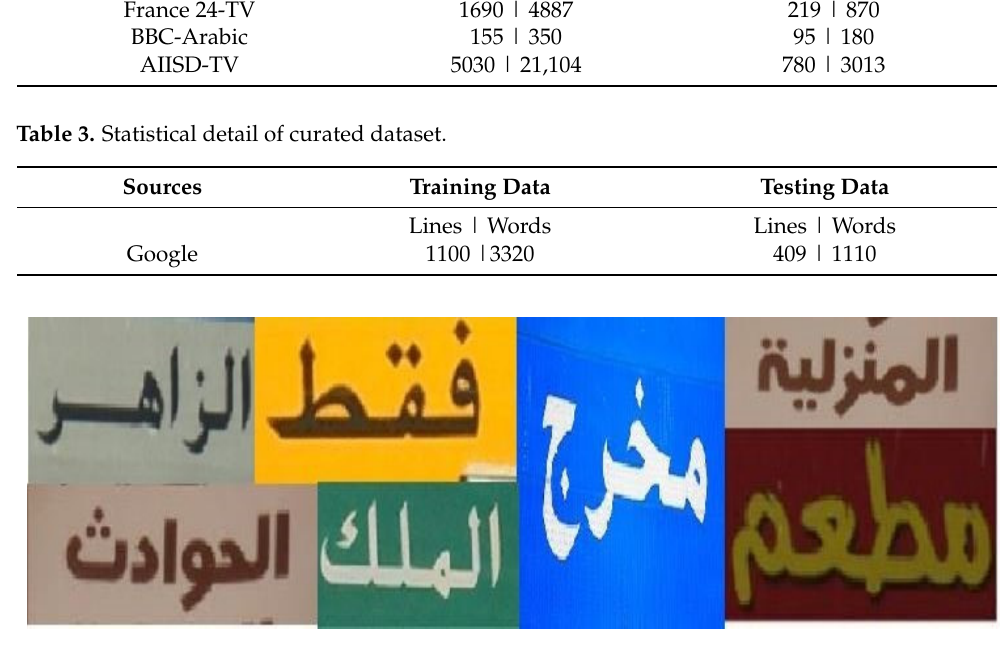
Table 1. Statistical detail of ACTIV dataset.